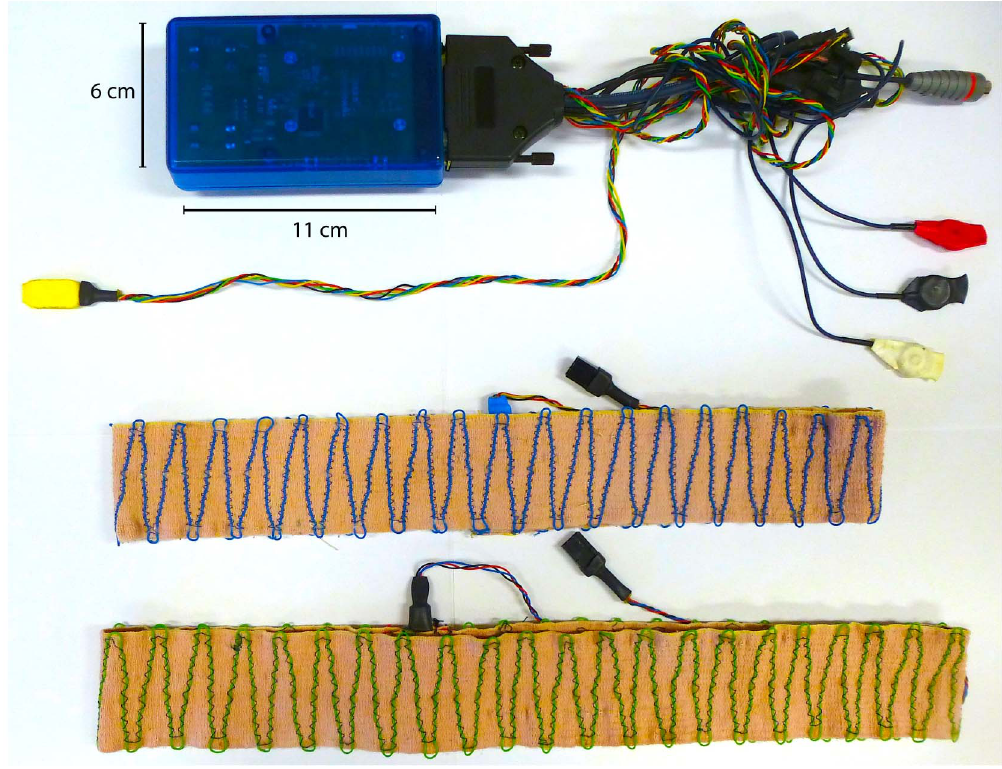
Figure 1. Portable experimental device. The device acquired electrocardiogram, respiratory excursion and arm movement, at the frequency of 400 Hz/channel. The data were acquired simultaneously from the ten participants and synchronized through a built-in XBEE radio module and saved on SD card.